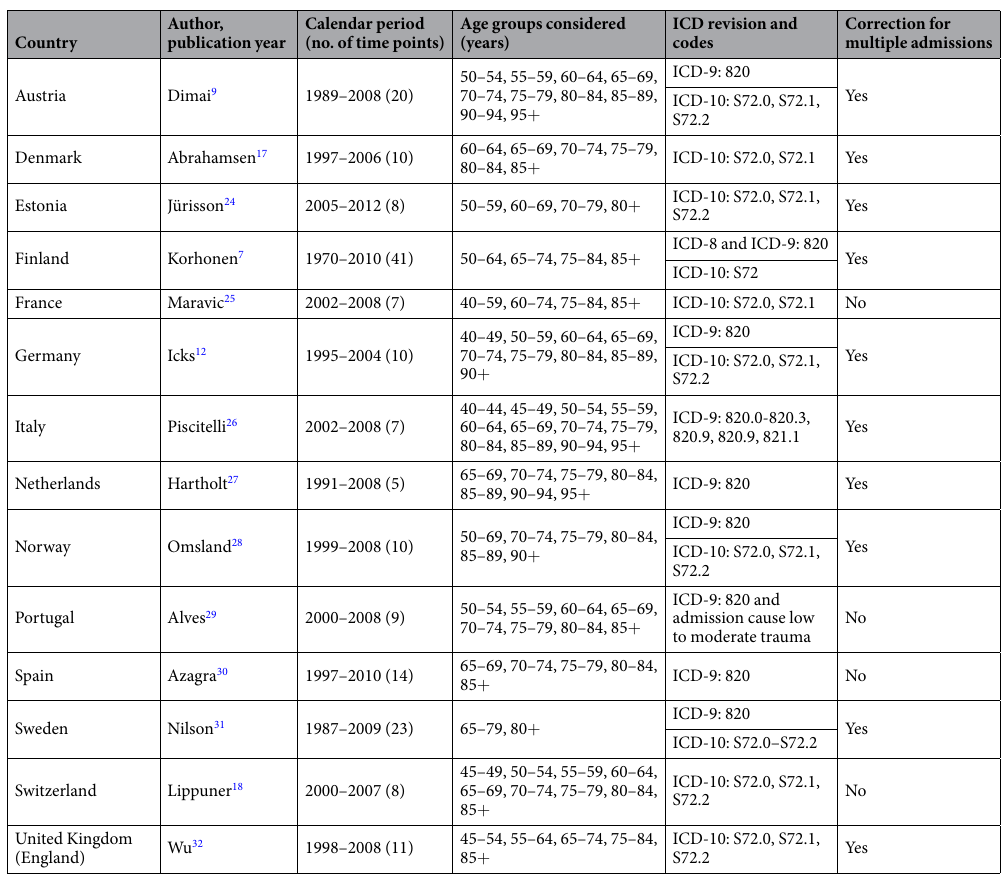
Table 1. Characteristics of studies